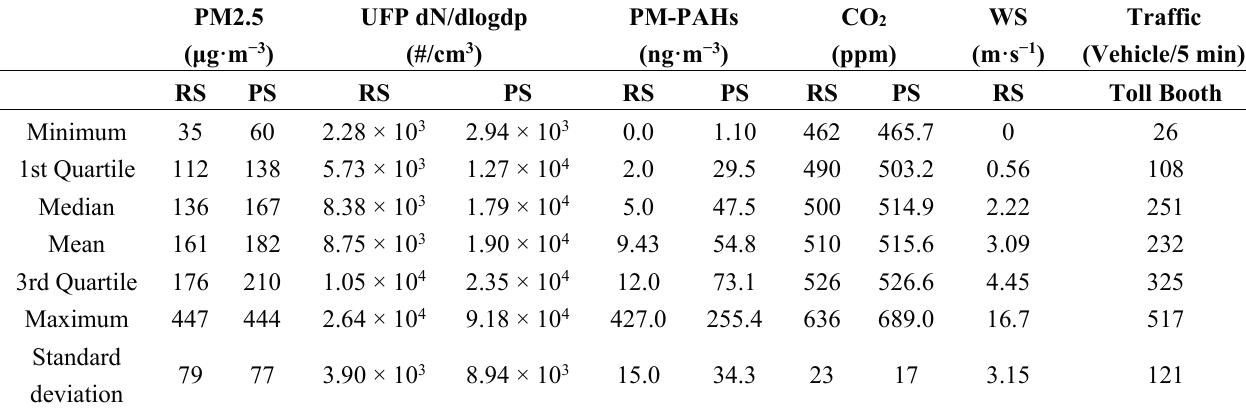
Table 3. Statistical descriptions of PM2.5, UFP, PM-PAHs CO 2 , WS and Traffic volume obtained from the police station (PS), reference station (RS), and toll